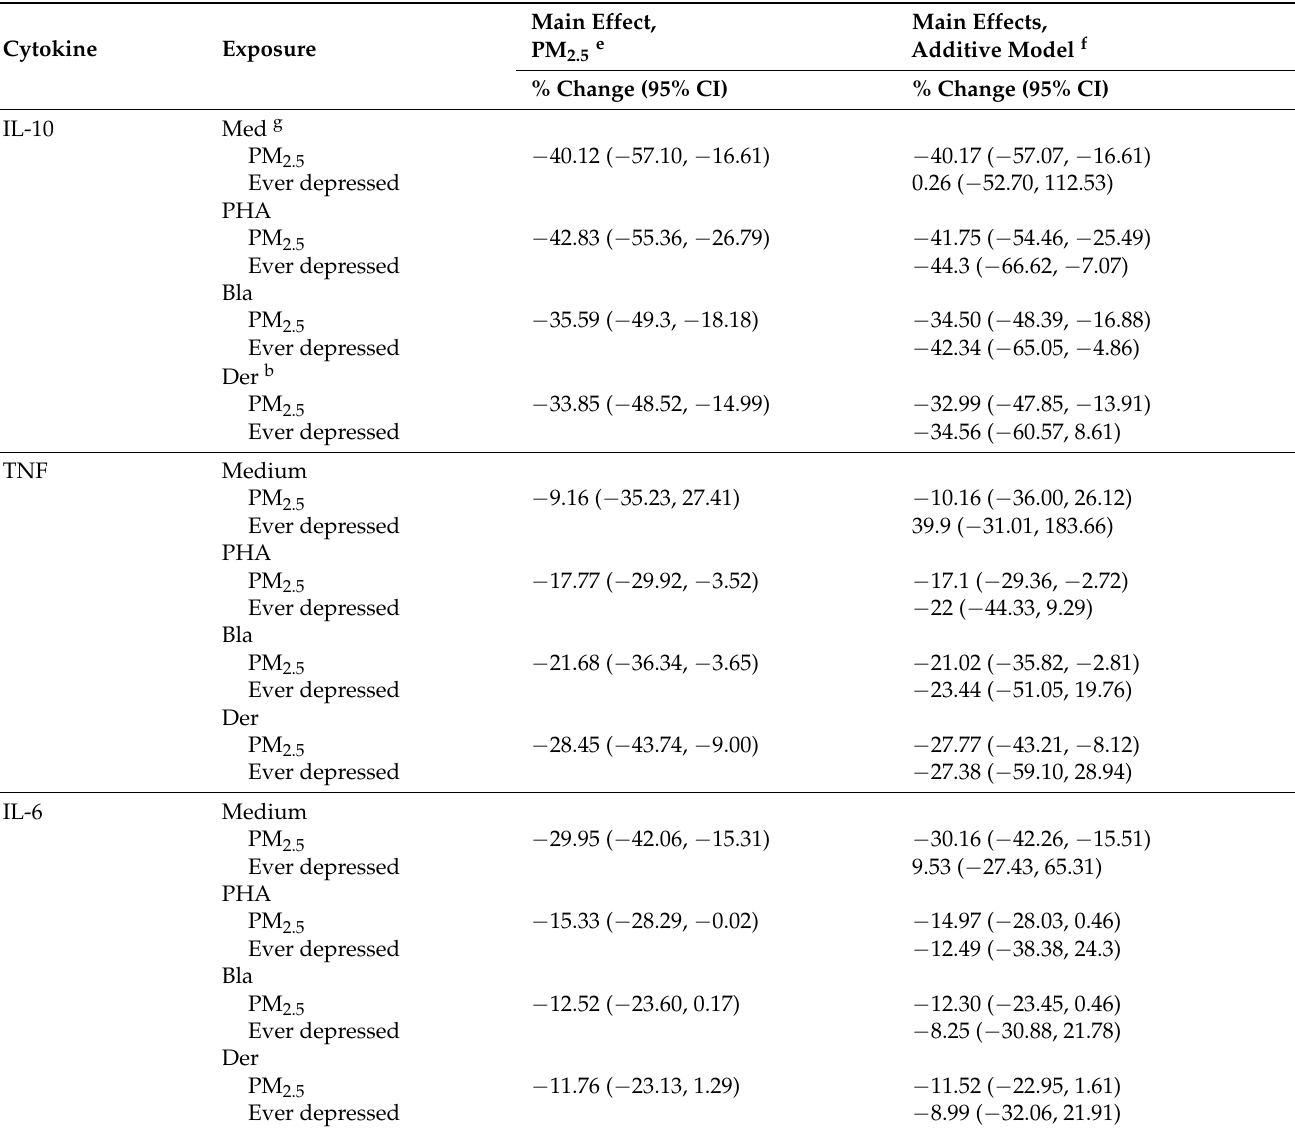
Table 2. Percent change in neonatal cord blood cytokine concentration a associated with exposure to PM 2.5 b and maternal depression c,d